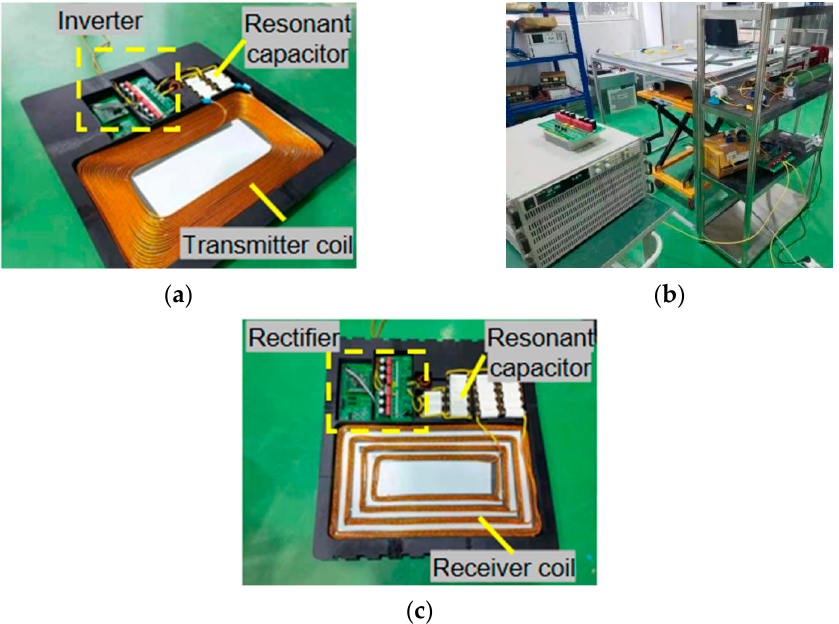
Figure 23. Wireless power transfer system packaging: ( a ) transmitter package, ( b ) receiver package, ( c ) WPT system. Table 3. WPT system parameters.